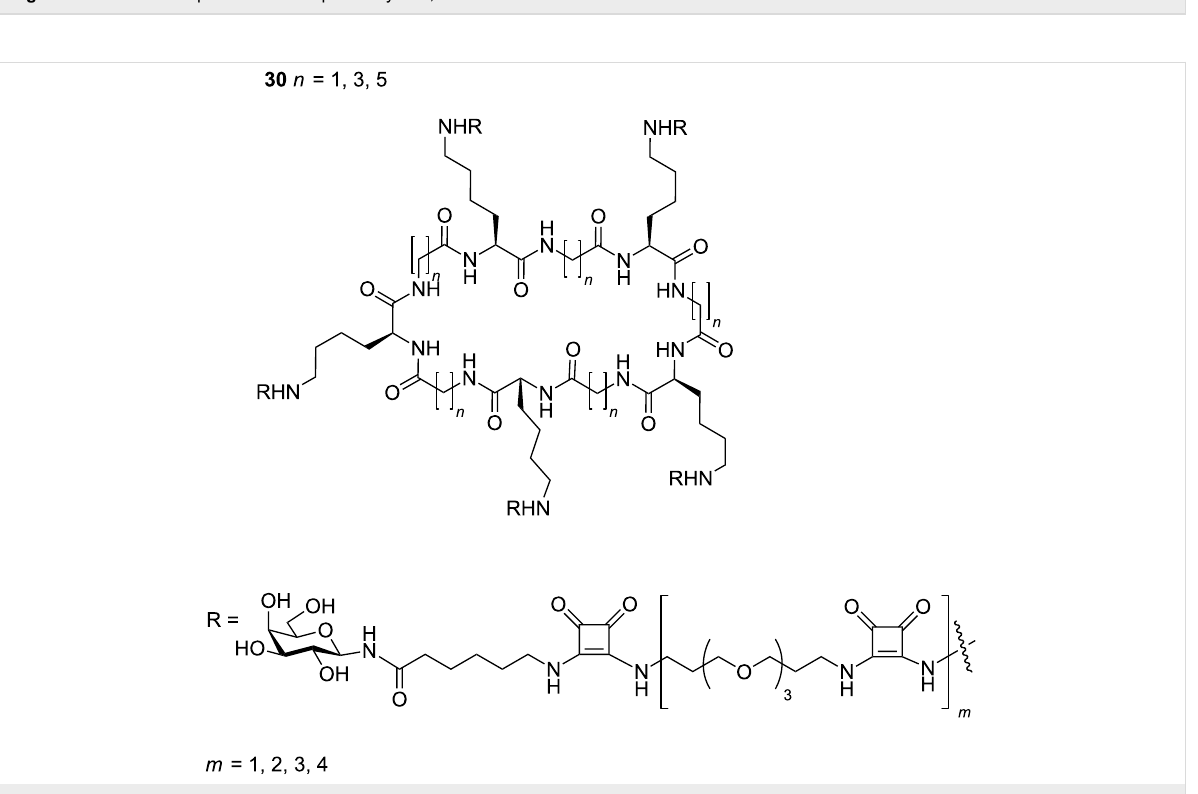
Figure 11: Differently sized cyclic decavalent peptide core designed by Zhang et al.